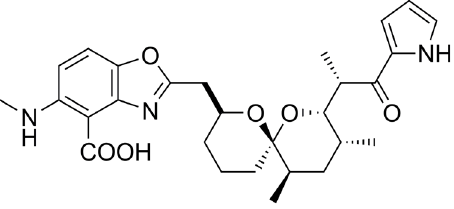
Figure 5: Functionalized nanozeolite by Piotrowska et al. for radium encapsulation.